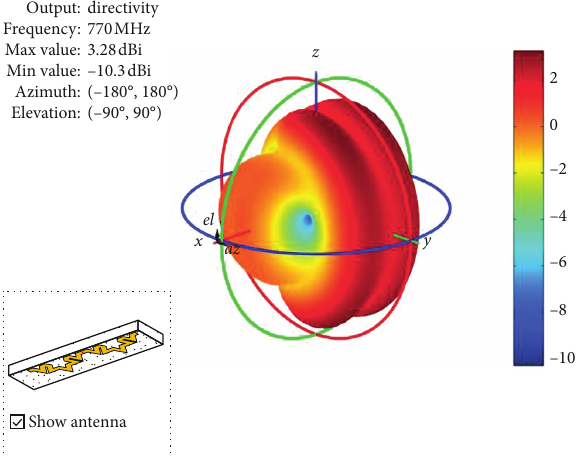
Figure 16: Two-iteration fractal Koch antenna radiation pattern and phase at